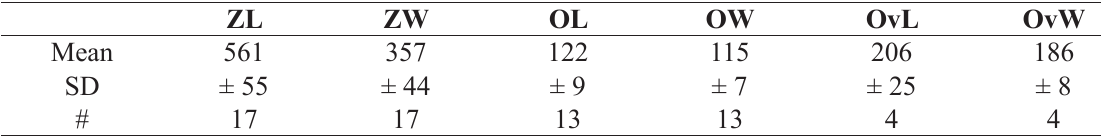
Table 3. Measurements of Atlantisina meteor gen. et sp.